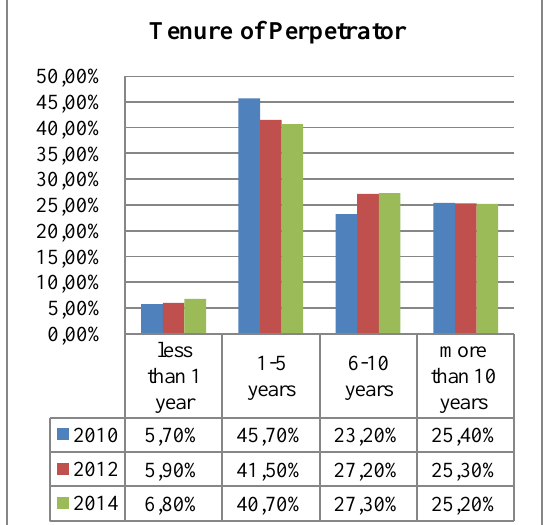
Figure 5. Tenure of